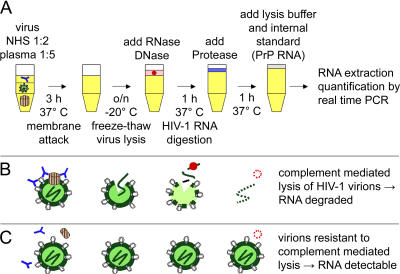
Schematic Overview of the Virion Lysis Assay(A) Primary HIV-1 virions were incubated with autologous plasma and complement and freeze-thawed once, and viral RNA was digested by RNase and DNase. After inactivation of RNase and DNase by protease and addition of an internal standard (PrP RNA), RNA was extracted and quantified by real-time PCR.(B) HIV-1 virions sensitive to antibody-mediated complement lysis were disrupted, making viral RNA accessible for degradation.(C) Viral RNA of complement lysis-resistant virions remained intact. RNA was extracted and could be quantified by real-time PCR.